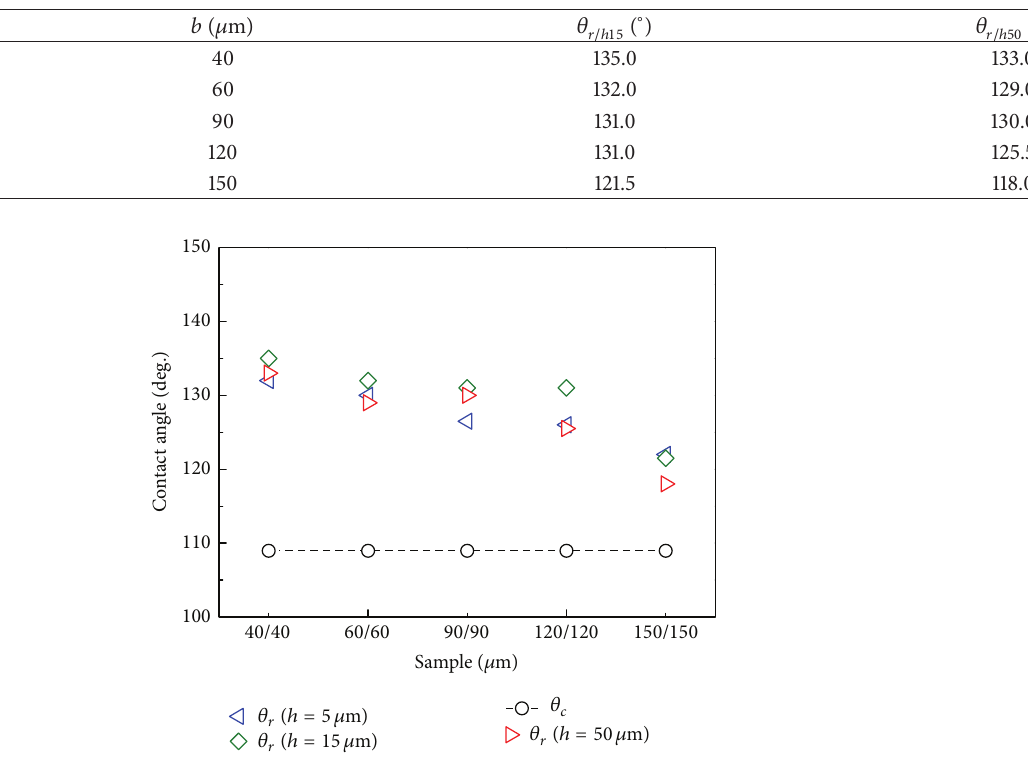
with 𝜃 𝑐 calculated from Cassie-Baxter equation (dashed